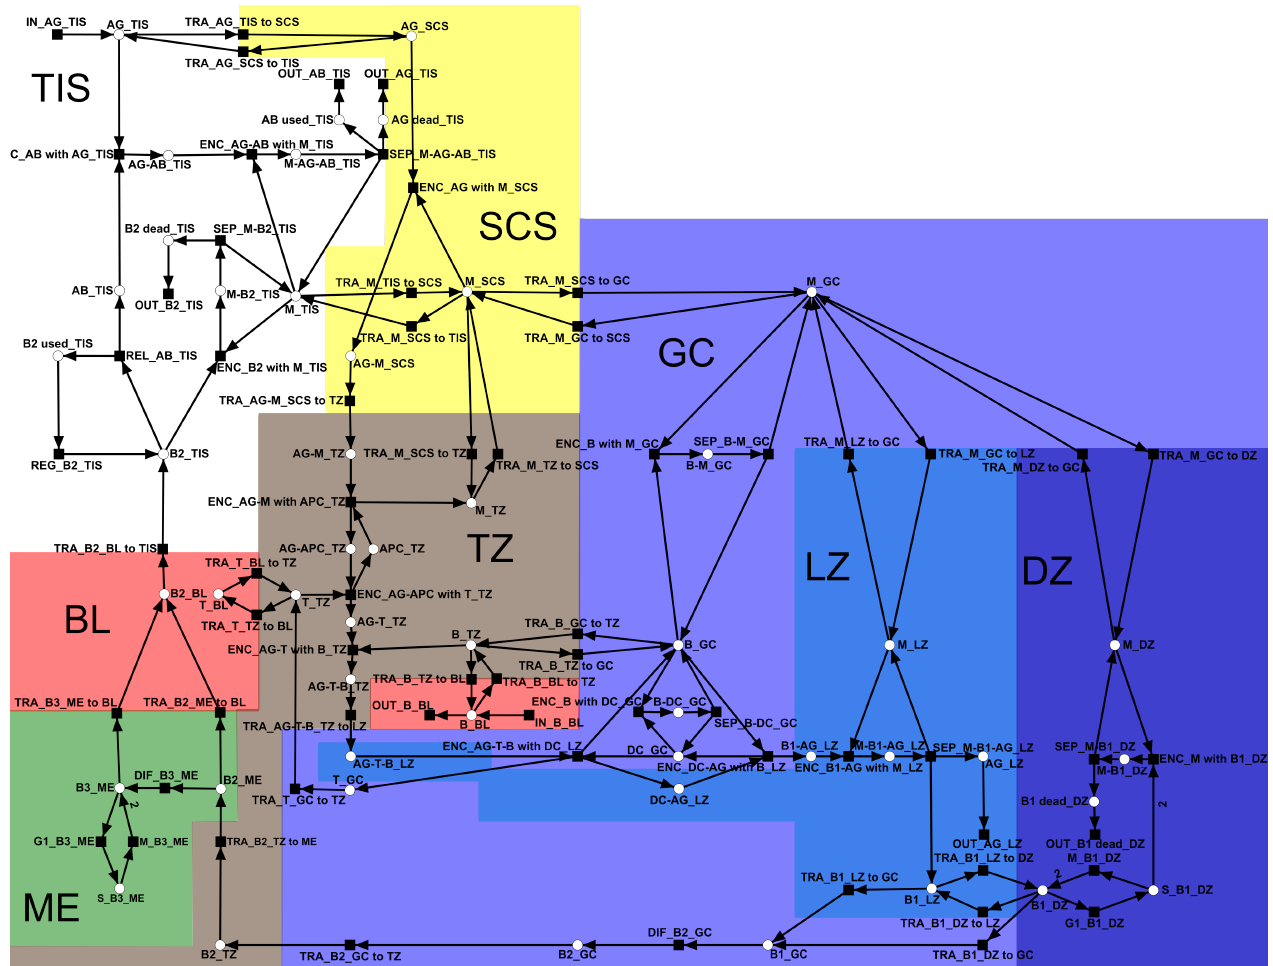
Figure 2. Petri net model of a lymph node. Rectangles, circles, and arcs represent transitions, places, and edges, respectively. Places denote cells, e.g., B cells, T cells, dendritic cells, and macrophages. Transitions denote cell interaction, activation, and migration. The lymph node (LN) is structured into the T zone (TZ, brown), germinal center (GC, blue), subcapsular sinus (SCS, yellow), medulla (ME, green), light zone (LZ, light blue), and dark zone (DZ, dark blue). Cells may enter and leave the lymph node via blood (BL, red) or tissue (TIS, not highlighted). For lists of places and transitions, refer to Tables A1 and A2 in Appendix A, respectively. For the reaction system, refer to Table A3 in Appendix